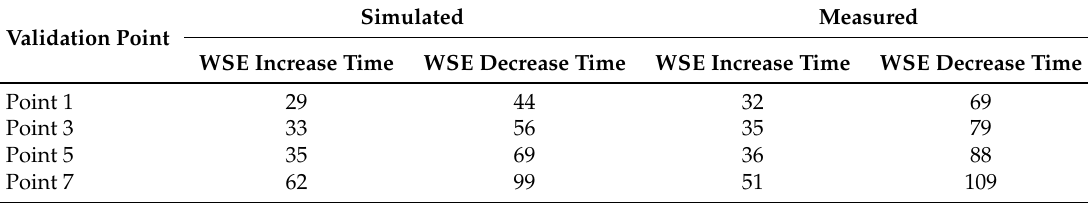
Figure 6. Hysteresis loop for WSE norm in validation points 1, 3, 5, and 7, given the measured scenarios in Figure 2 and the simulated scenarios described in Section 3.3.1. ( a ) Simulated hysteresis loop. The arrows indicate the direction of the process. ( b ) Measured hysteresis loop. Table 4. Time for each leg of the hysteresis loop for WSE norm obtained from Figure 6. The time it takes for the WSE to reach the new steady state is referred to as increase time and decrease time . All units of time are in